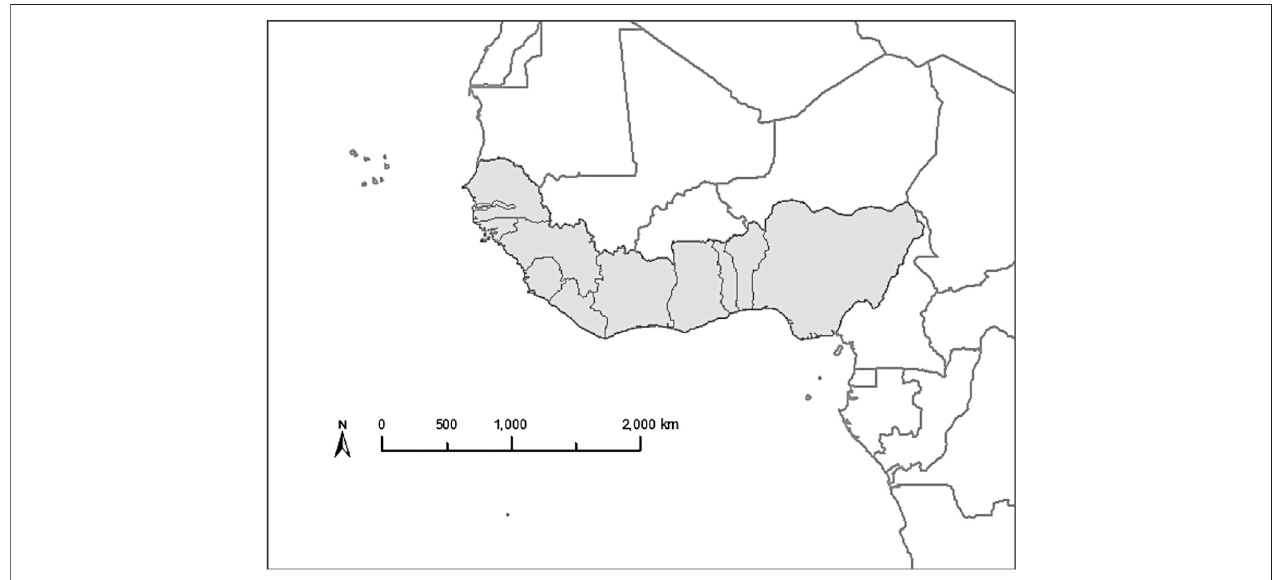
FIGURE1| Illustration ofthestudyarea, including 11coastal countriesinWest Africa, namelySenegal, TheGambia,GuineaBissau,Guinea, SierraLeone, Liberia, C ˆ ote d ’ Ivoire, Ghana, Togo, Benin, and Nigeria.